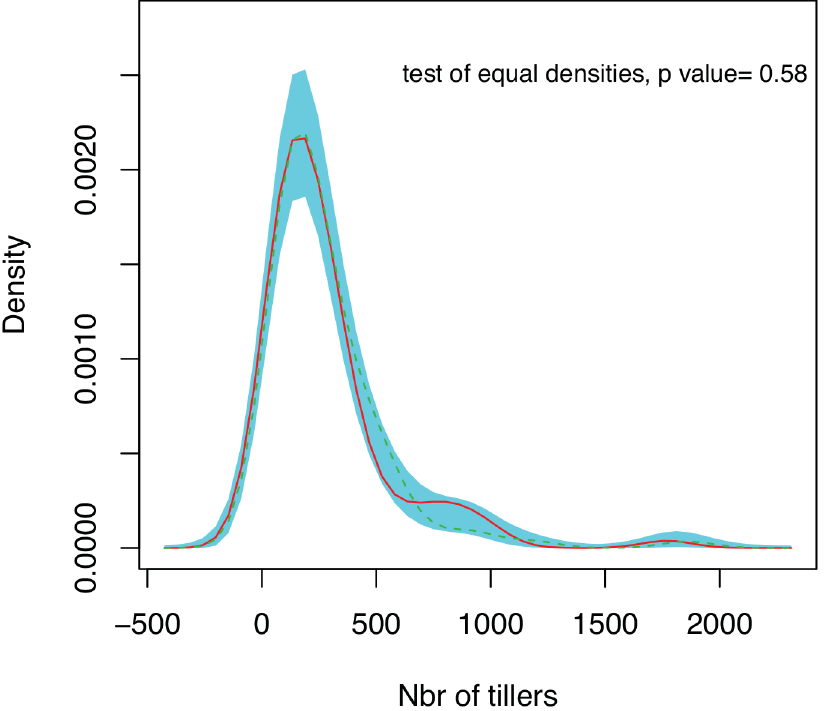
Fig 2. Size distribution of Festuca eskia plants at the Guzet site (France), as a function of the presence (red line) or absence (green line) of the fungal endophyte Epichloe festucae . CI ± 95% is in turquoise.